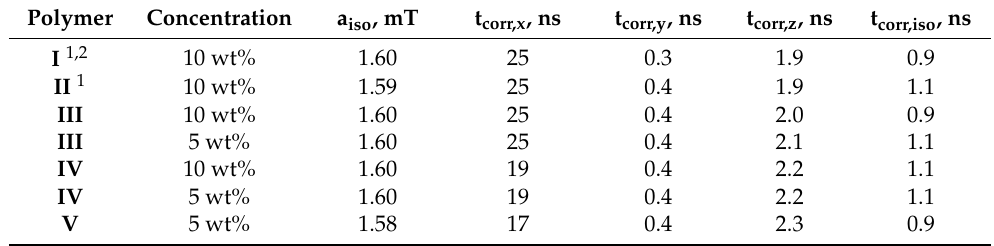
1 Data from modeling the spectra of TEMPO polymer solutions without Cu 2+ ions. 2